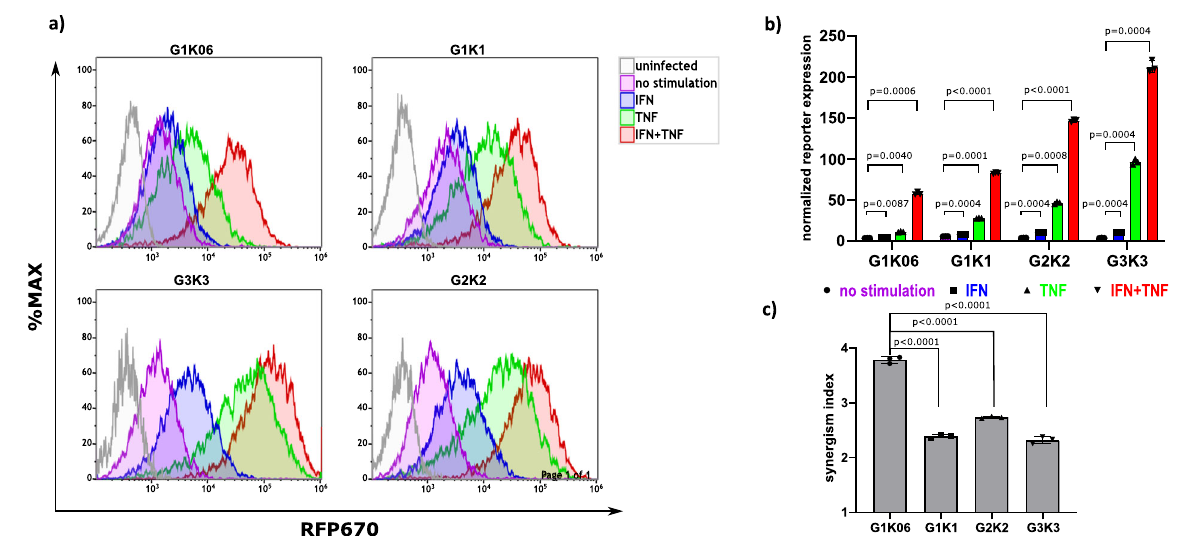
Fig. 2 CARTIV promotors show a robust and additive effect with IFN γ and TNF α stimulation in HEK293 cells. a Representative FACS plots of HEK293T cells infected using lenti viral vectors with RFP670 under the control of the indicated CARTIV promotor and ZsGreen controlled by the ef1 α core promotor. At 72 h following infection, the cells were incubated for 48 h with the indicated cytokines (250 U/mL for each cytokine), harvested and analyzed by fl ow cytometry. Data shown are ZsGreen-positive, single-discriminated, and DAPI-negative results. b Geometric mean of RFP670 in ZsGreen-positive cells normalized to uninfected cells, showing average of triplicates, error bars indicate standard deviation, A two way ANOVA was performed. c Synergism level calculated by dividing the geometric mean of ZS + cells stimulated with IFN and TNF by the geometric mean of cells stimulated with IFN or TNF. A one-way ANOVA was performed, error bars indicate standard deviation. Results are from one representative experiment of three full experiments performed (including the G2K2); the G1K0.6, G1K1, and G3K3 were compared in more than eight independent